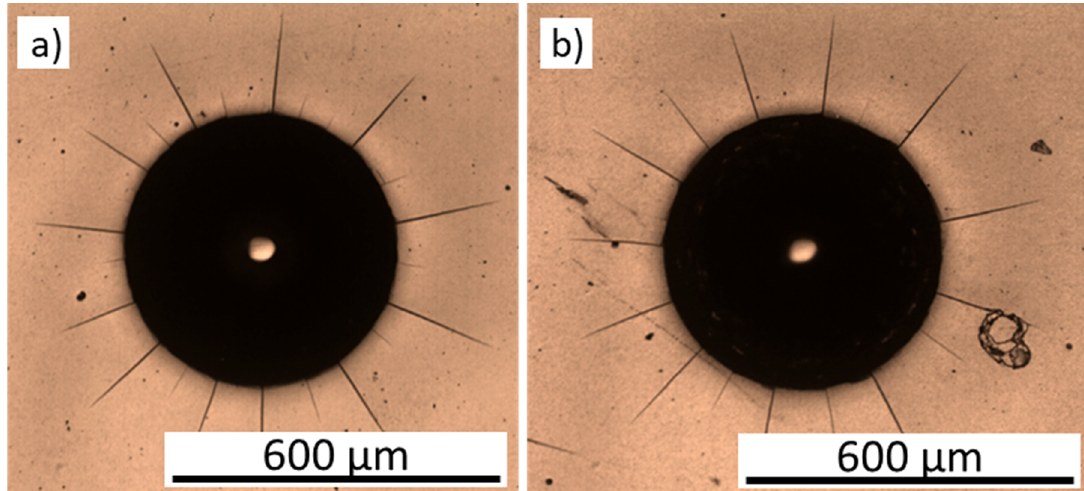
Figure 11. Images of the indented surface showing only radial cracks, classified as HF-1: (a) DLC-1 and (b) DLC-2. No spalling was observed.